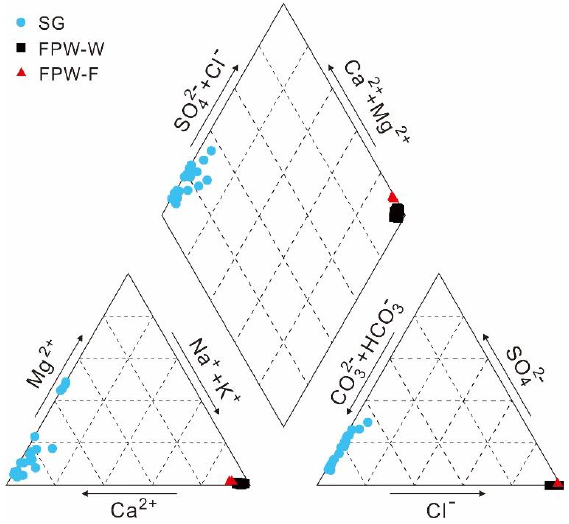
Figure 2. The Piper diagram of shallow groundwater (SG) of the Xishui region, flowback and produced water from Weiyuan (FPW-W) and Fuling (FPW-F).